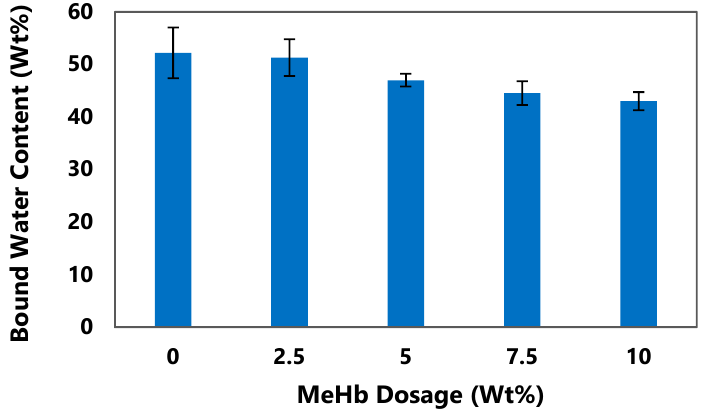
Figure 7. Bound water content in biosludge at different dosage of methylated hemoglobin.